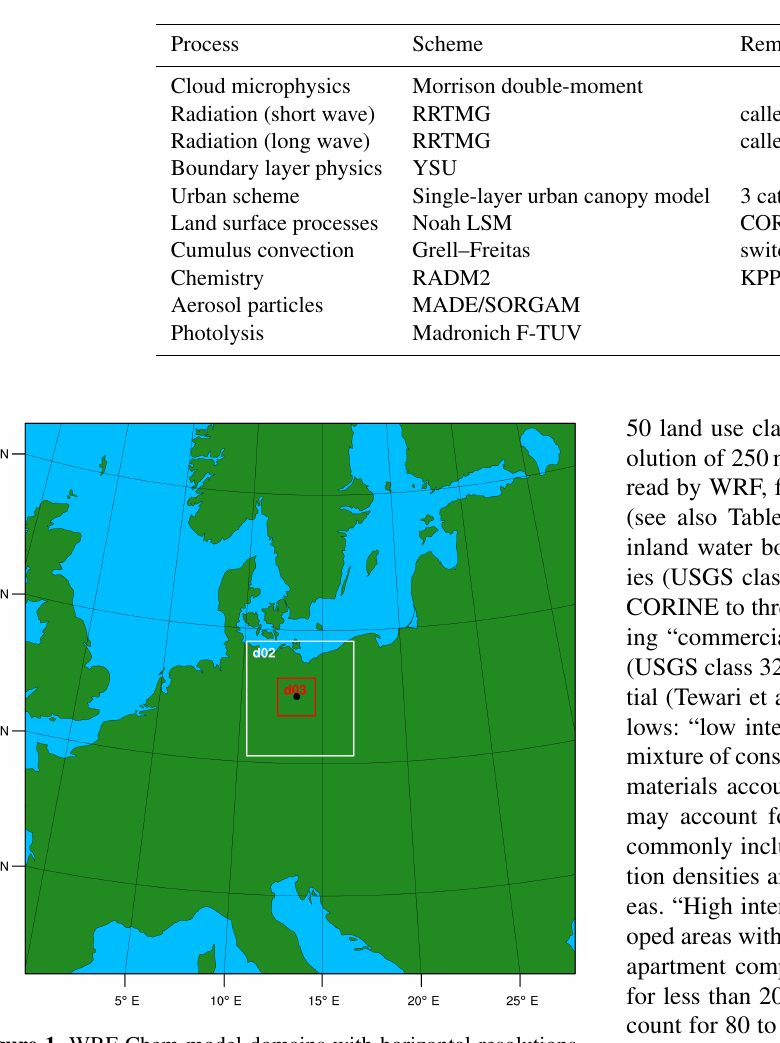
Figure 1. WRF-Chem model domains with horizontal resolutions of 15km (d01, outer domain), 3km (d02, middle domain) and 1km (d03, inner domain), centred around Berlin, Germany, which is marked black in the